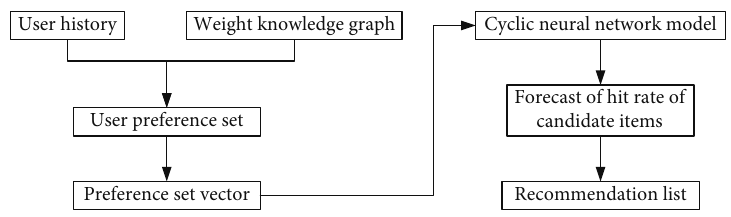
Figure 4: RNWKG algorithm fl ow chart.